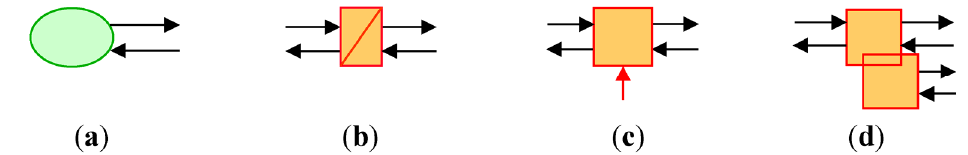
Figure 3. ( a ) Source of energy; ( b ) Element with energy accumulation; ( c ) Electrical converter (without energy accumulation); ( d ) Electrical coupling (without energy